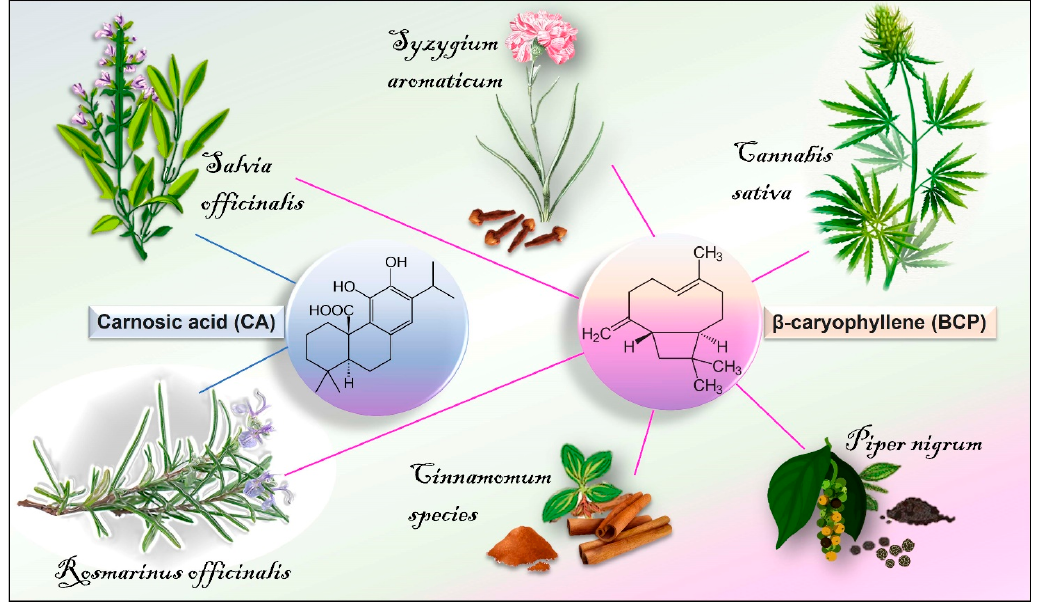
Figure 1. Chemical structures and main natural sources of β -caryophillene and carnosic acid.